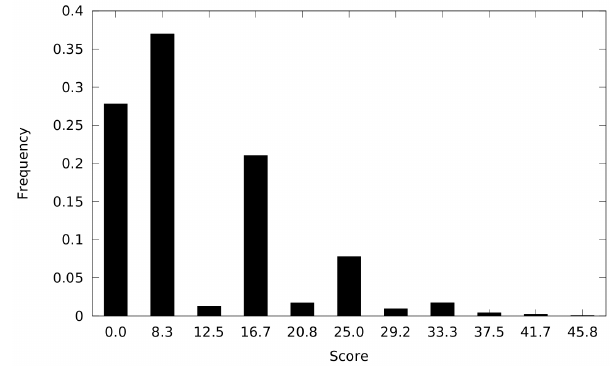
Figure 3. Empirical distribution of random tree scores. Ten thousand random matrices R 1 , R 2 , ... , R 10000 were created from the matrix used to create the sample dendrogram in Figure 1 by randomly rearranging the peptide intensity values within each sample. For each score d 0 ( R i ) that was given to at least one random tree, the frequency of that score is